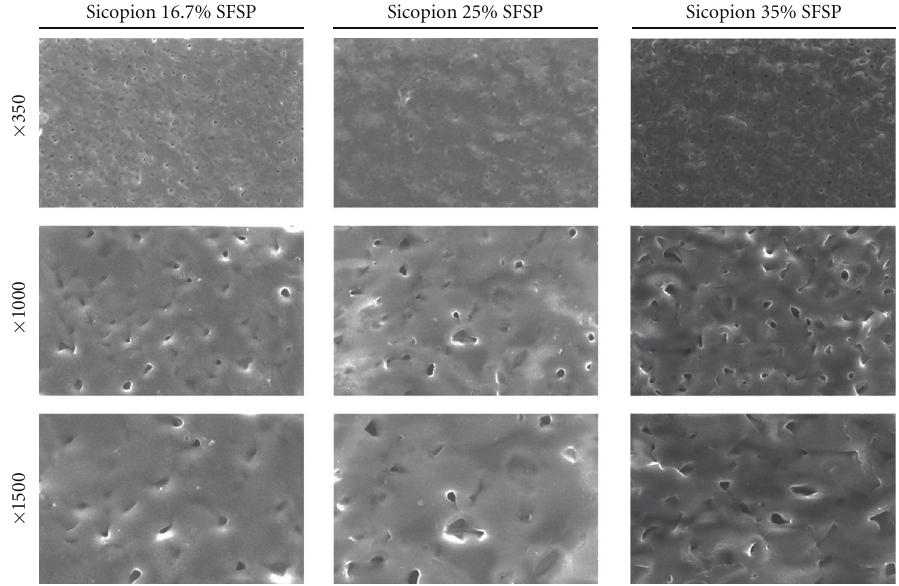
Figure 7: Scanning electron micrographs (SEMs) of Sicopion membranes.